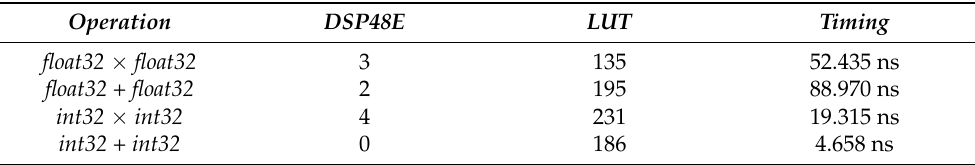
Table 3. Summary of the hardware resources and timing in an FPGA by performing addition and multiplication operations with two 32-bit numbers using fixed point and floating point (int32 and float32, respectively).